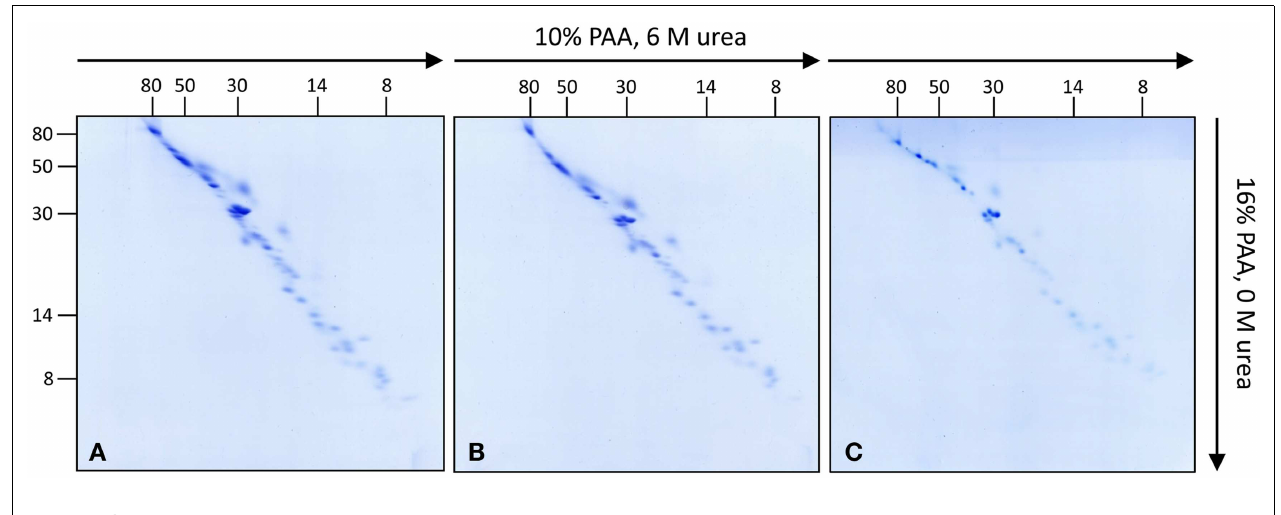
FIGURE 1 | Investigation of complex I subunits from different tissues of Arabidopsis thaliana by 3D BN/SDS/SDS-PAGE .Total mitochondrial protein from cell culture, leaves, and roots (1200 µ g each) was resolved by BN-PAGE in a first dimension. Complex I was cut out from the BN gel and used for second gel dimensions [SDS-PAGE within a 10% polyacrylamide (PAA) gel in the presence